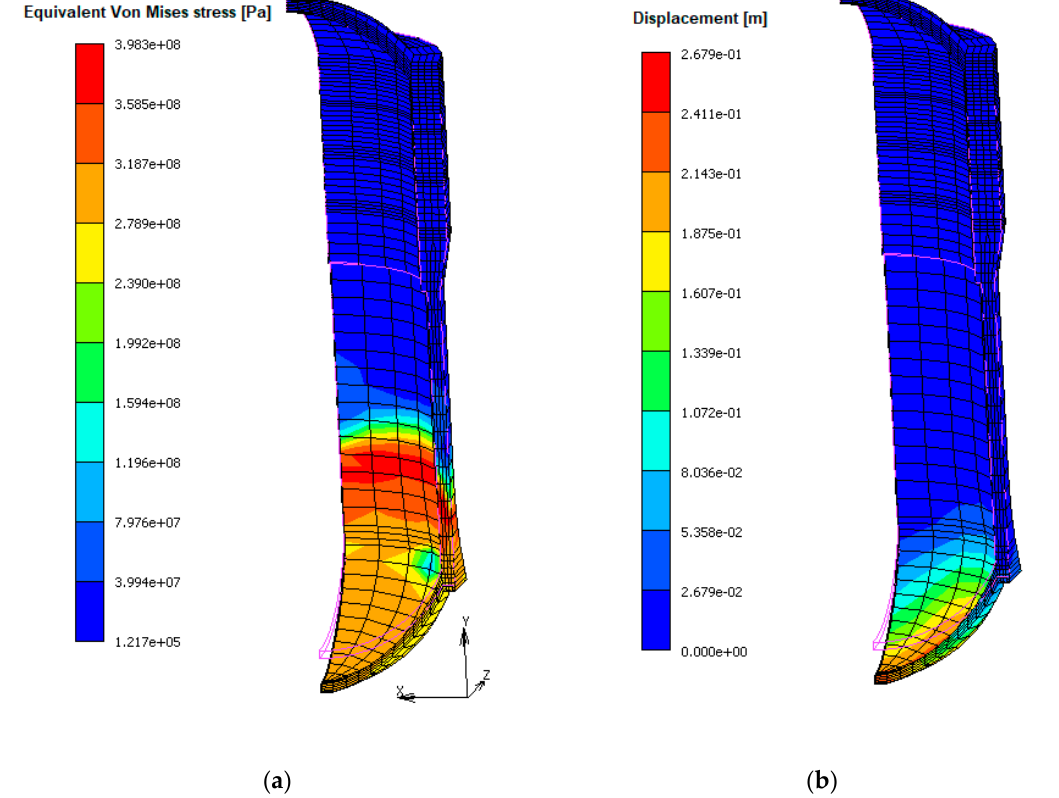
Figure 14. Qualitative deformed vs. undeformed (magenta edge contour) shape contour plot of Von Mises stress ( a ) and displacement module ( b ) at t = 20,570 s for aged RPV affected by creep.